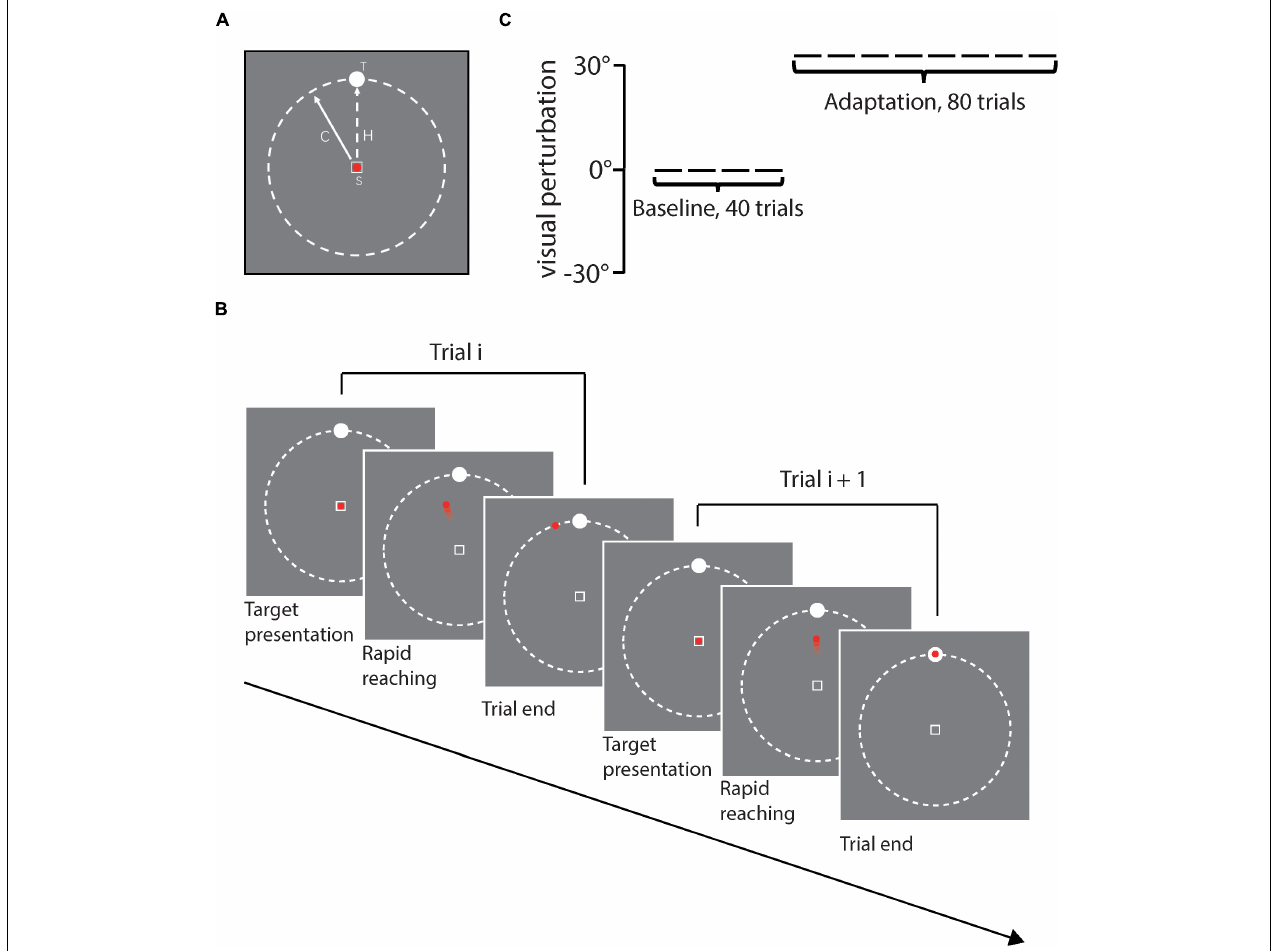
FIGURE 2 | (A) Illustrates stimuli presented on each trial, including the start position (S) with the red point cursor inside, and white circular target (T). The solid line with arrow represents the cursor moving direction and the dash line represents the actual hand movement direction (H). (B) Illustrates the task procedure of two sample trials, (C) illustrates the experiment design for each participant, including first 40 baseline trials and then 80 adaptation trials. Rotation direction perturbation was fixed to 30 ◦ counterclockwise in reference to the actual hand movement direction in the adaptation